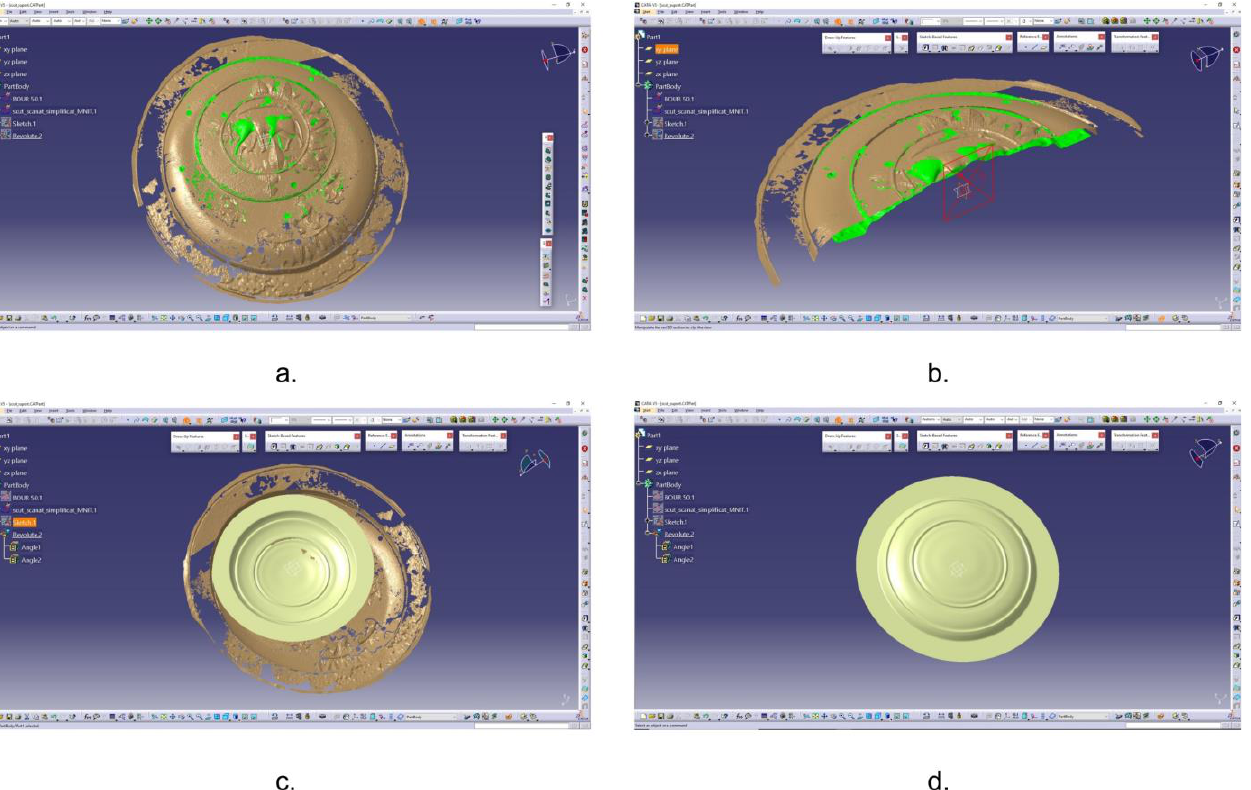
Figure 15. ( a ) The overlap between the fragmented embossed disk and the reference embossed disk with an aurochs from National Museum of Romanian History; ( b ) Section cut between the two embossed disks in the middle; ( c ) Bottom view of the 3D model support disk; ( d ) The final 3D model of the support.